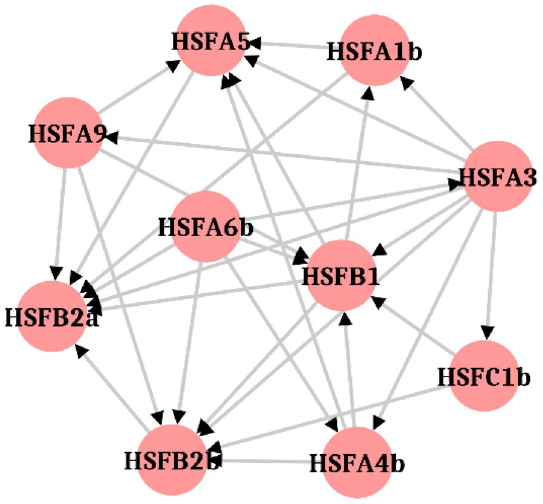
Figure 4. Protein–protein interaction (PPI) network analysis exhibiting interaction of HSF proteins with one another. In the network, the nodes correspond to the proteins and the edges represent the interactions. Arrows represent the interaction between one HSF protein with another by degree value. The source and points of arrows show the sources and targets of HSF protein in the network. More arrows at a node mean more number of HSF proteins are interacting with that particular